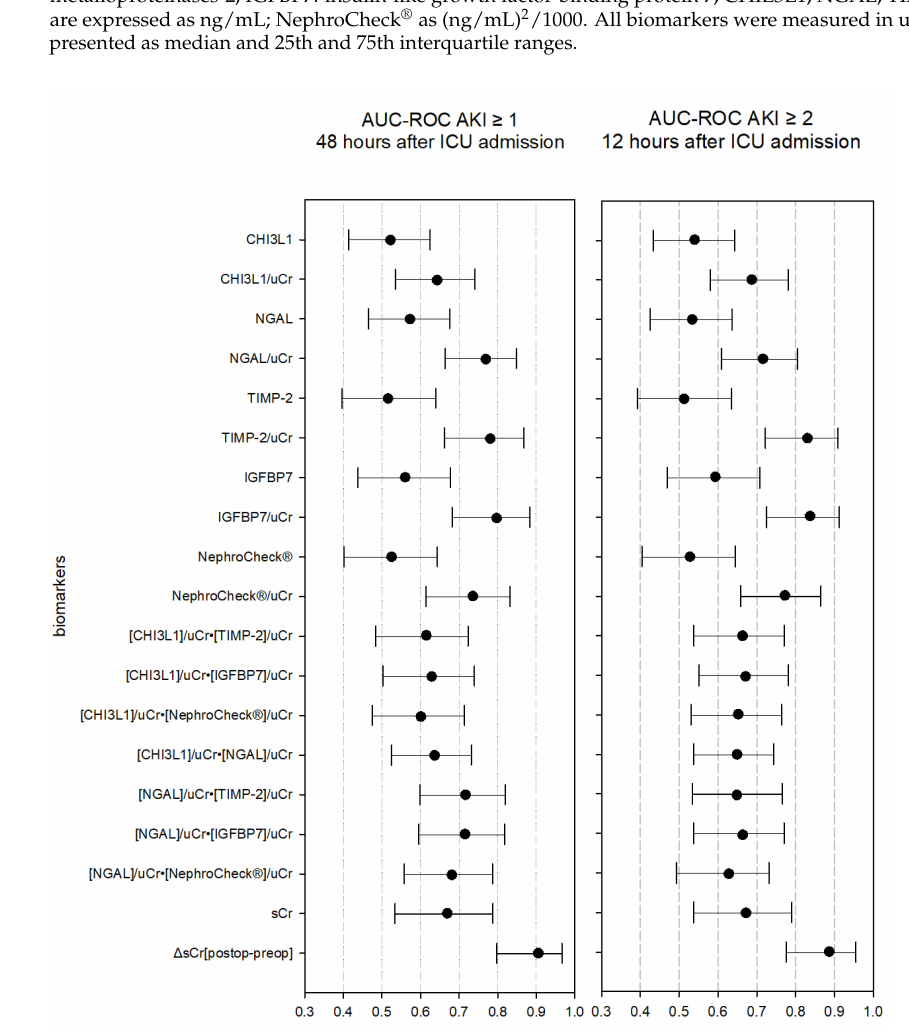
Figure 3. Performance of biomarkers and combinations of biomarkers in predicting acute kidney injury with and without correction for urine dilution. AKI: acute kidney injury; AUC-ROC: area under the receiver-operating characteristics curve; IGFBP7: insulin-like growth factor-binding